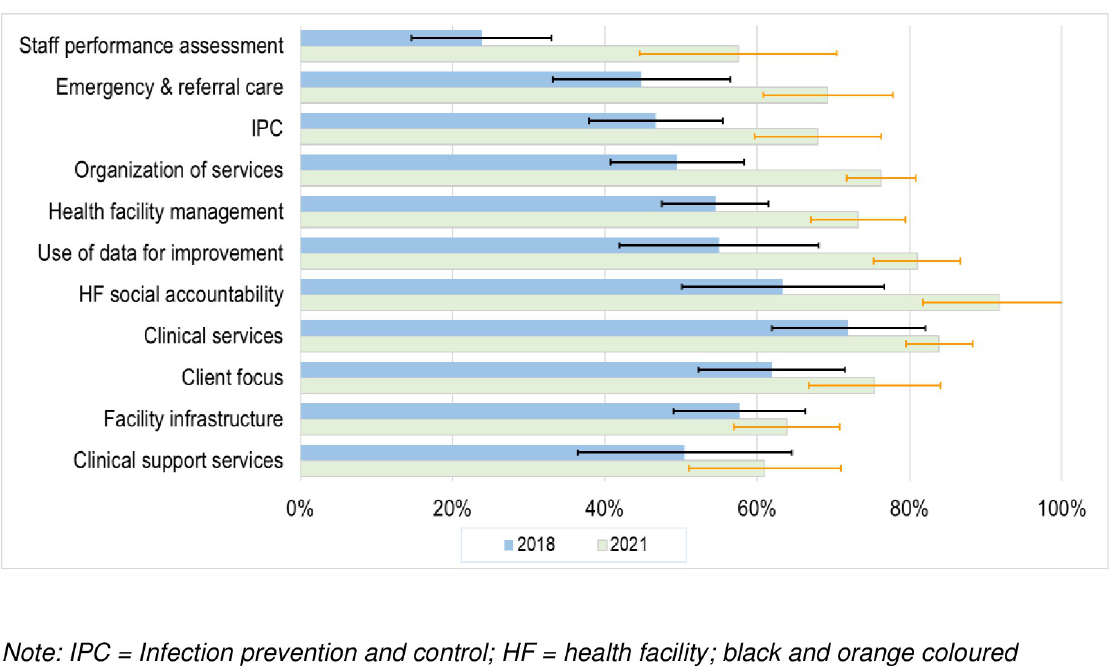
Fig 2. Score of the BRN key domains before and after capacity building in the ledership and